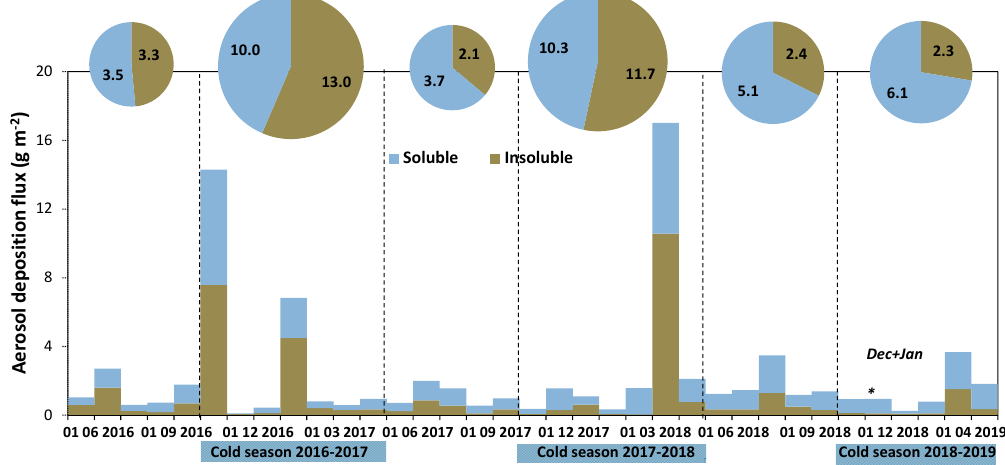
Figure 3. Monthly and seasonal aerosol soluble and insoluble fluxes (g m − 2 ) recorded in the Ordesa and Monte Perdido National Park (Central Pyrenees, Spain) from June 2016 to June 2019. * stands for a combined two-month sample instead of a 30-days